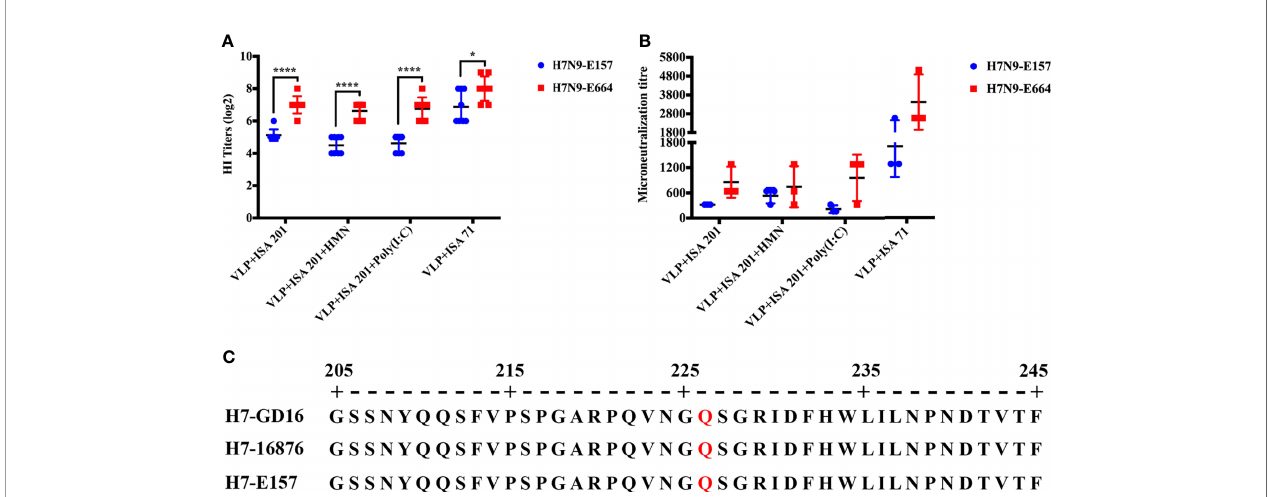
FIGURE 6 | Q226 mutation of H7 HA decreases readouts of HI and neutralizing antibody titers. (A) HI titers of H7N9-VLP immune sera from chickens to H7N9- E157 and H7N9-E664 viruses. (B) Neutralizing antibody titers of H7N9-VLP immune sera from chickens to H7N9-E157 and H7N9-E664 viruses. (C) Sequence alignment of HA gene of the H7N9-GD16, H7N9-E157, and H7N9-E664 viruses. H7N9-GD16, A/Guangdong/17SF003/2016 (H7/GD16). Statistically signi fi cant differences are indicated by an asterisk as follows: * p < 0.05, **** p <